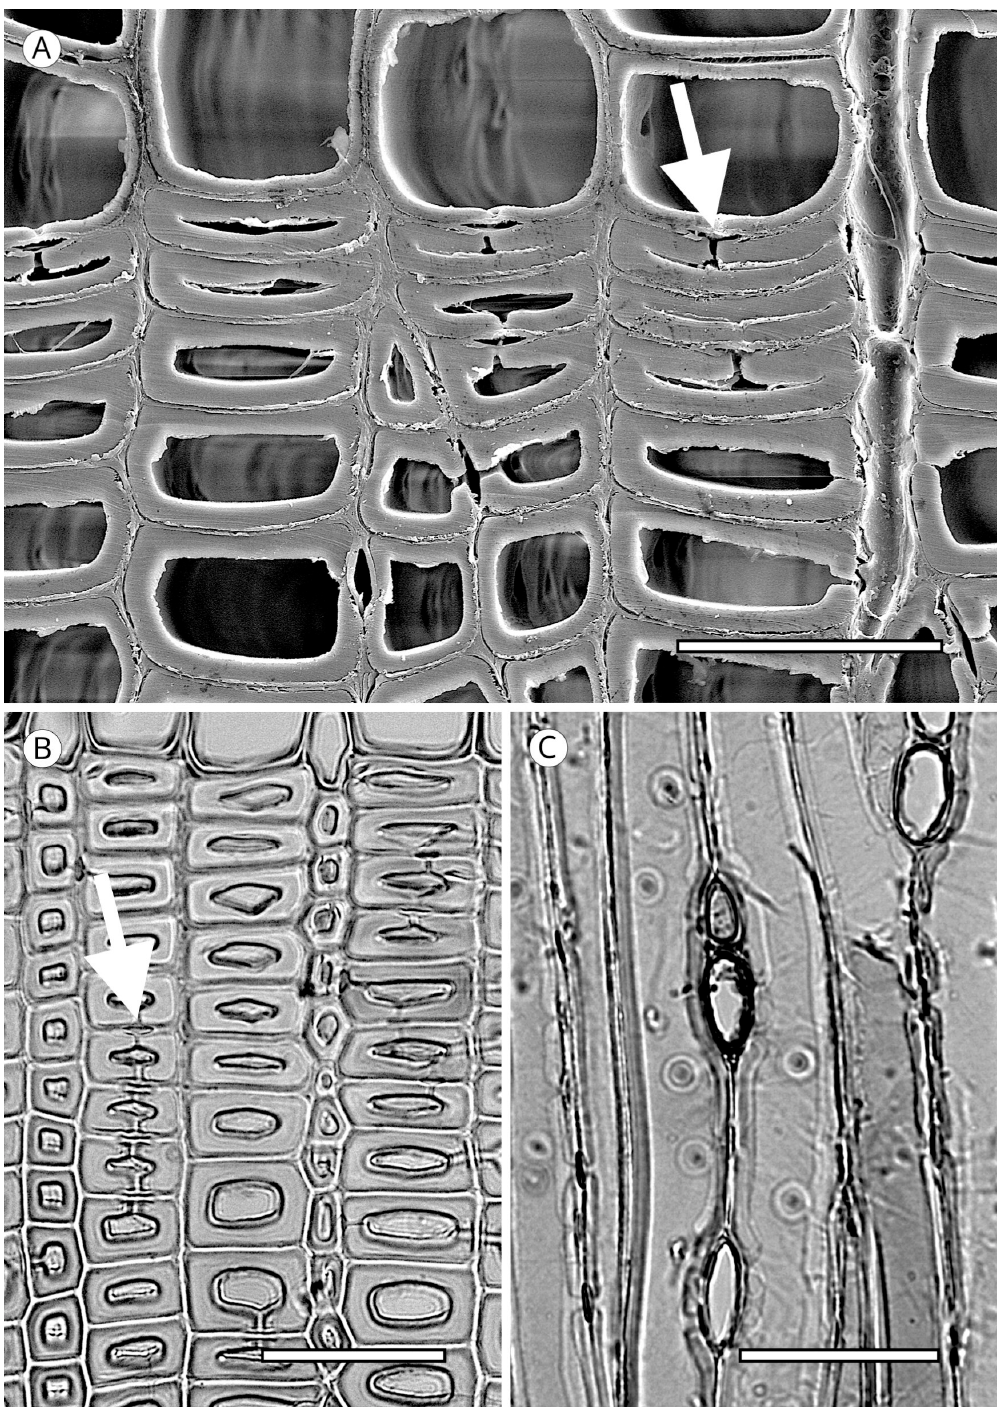
Figure 11. Tangential pits. ( A ) Tangential pits in transverse section in Chamaecyparis obtusa (Siebold & Zucc.) Endl. (SEM); ( B ) Tangential pits in transverse section in Athrotaxis selaginoides D.Don; ( C ) Tangential pits in tangential section in Tetraclinis articulata (Vahl) Mast. Scale bars. ( A – C ) = 50 μ m. The diameter of radial wall pits usually occupies two thirds of the axial tracheid diameter, although in Dacrydium and Podocarpus it can be less than half the tracheid diameter. This feature must be used with caution and only as a guideline, due to considerable intra-species variability [57] (Figure 13).